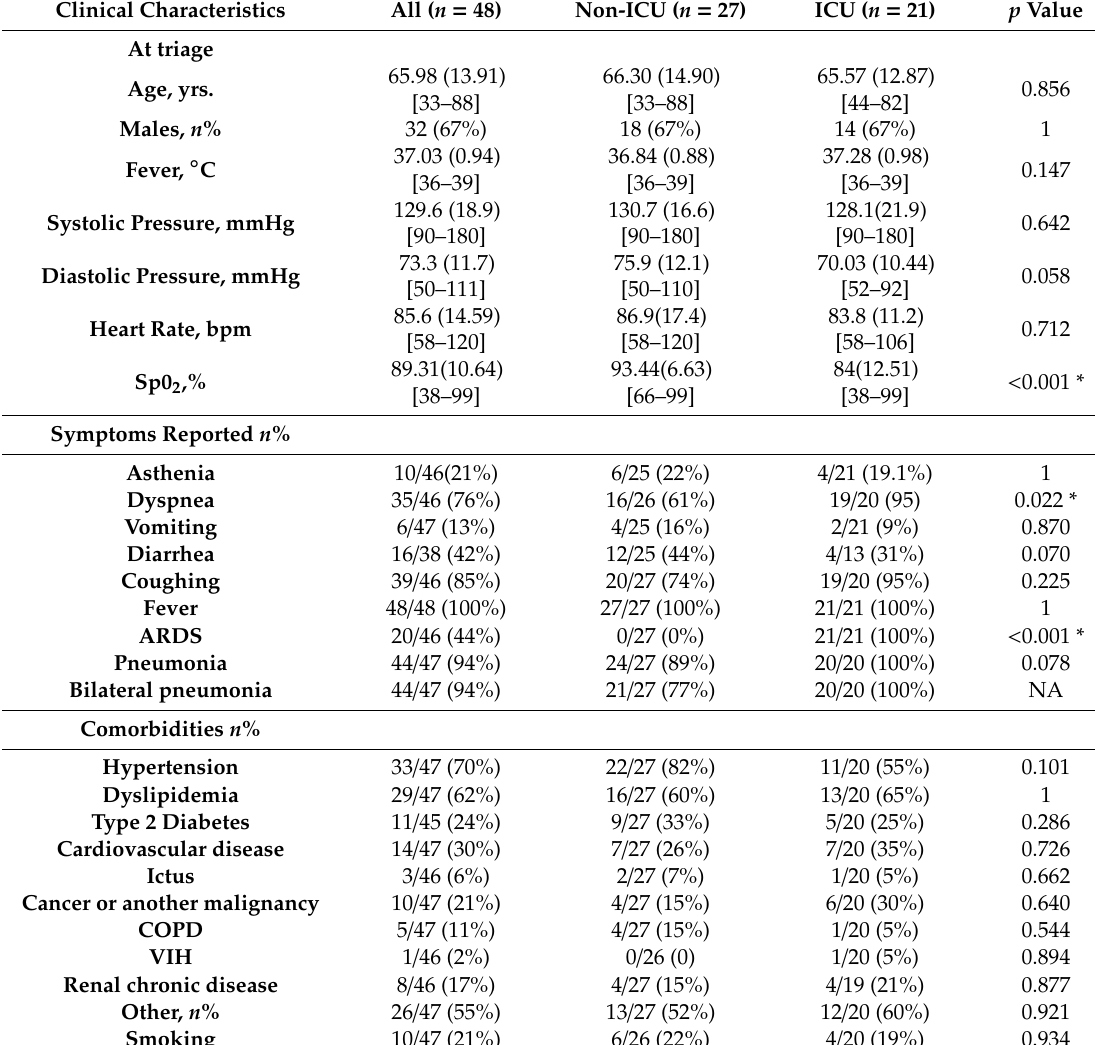
Table 1. Baseline characteristics of 48 patients with COVID-19 at triage, prior to